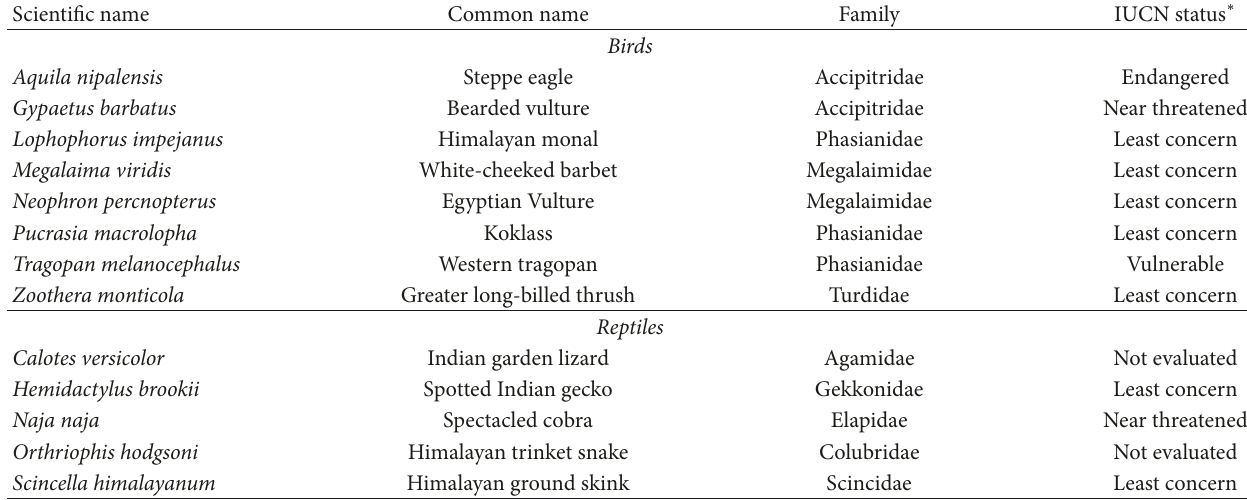
Table 10: List of birds and reptiles (with IUCN conservation status) found in Tungnath